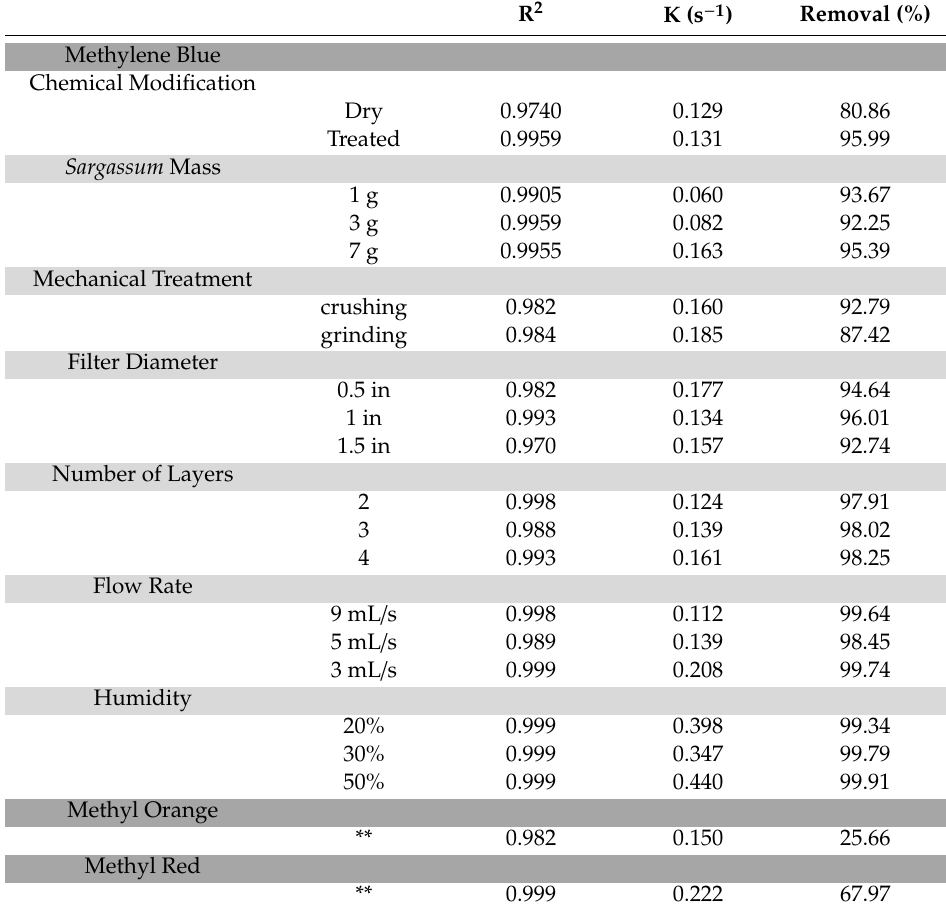
Table 1. Physicochemical parameters and removal percentages obtained from the organic dye absorption